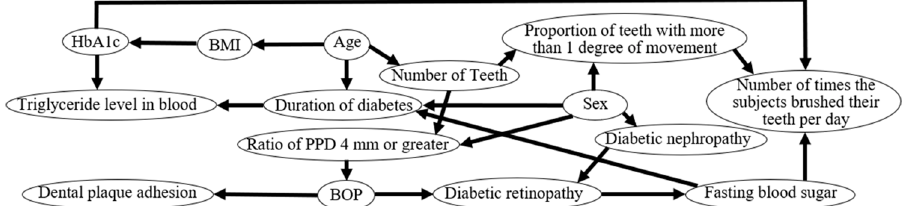
Figure 1. Bayesian network showing the causal effects among the following parameters: gender, age, number of teeth, bleeding on probing (BOP), ratio of probing pocket depth (PPD) of 4 mm or greater, proportion of teeth with more than 1 degree of movement, dental plaque adhesion, number of times the patients brushed their teeth per day, duration of diabetes, body mass index (BMI), fasting blood sugar, hemoglobin A1c (HbA1c), presence of diabetic retinopathy, presence of diabetic nephropathy, and triglyceride level in the blood. Causes and effects are indicated by arrowheads and lines, respectively.